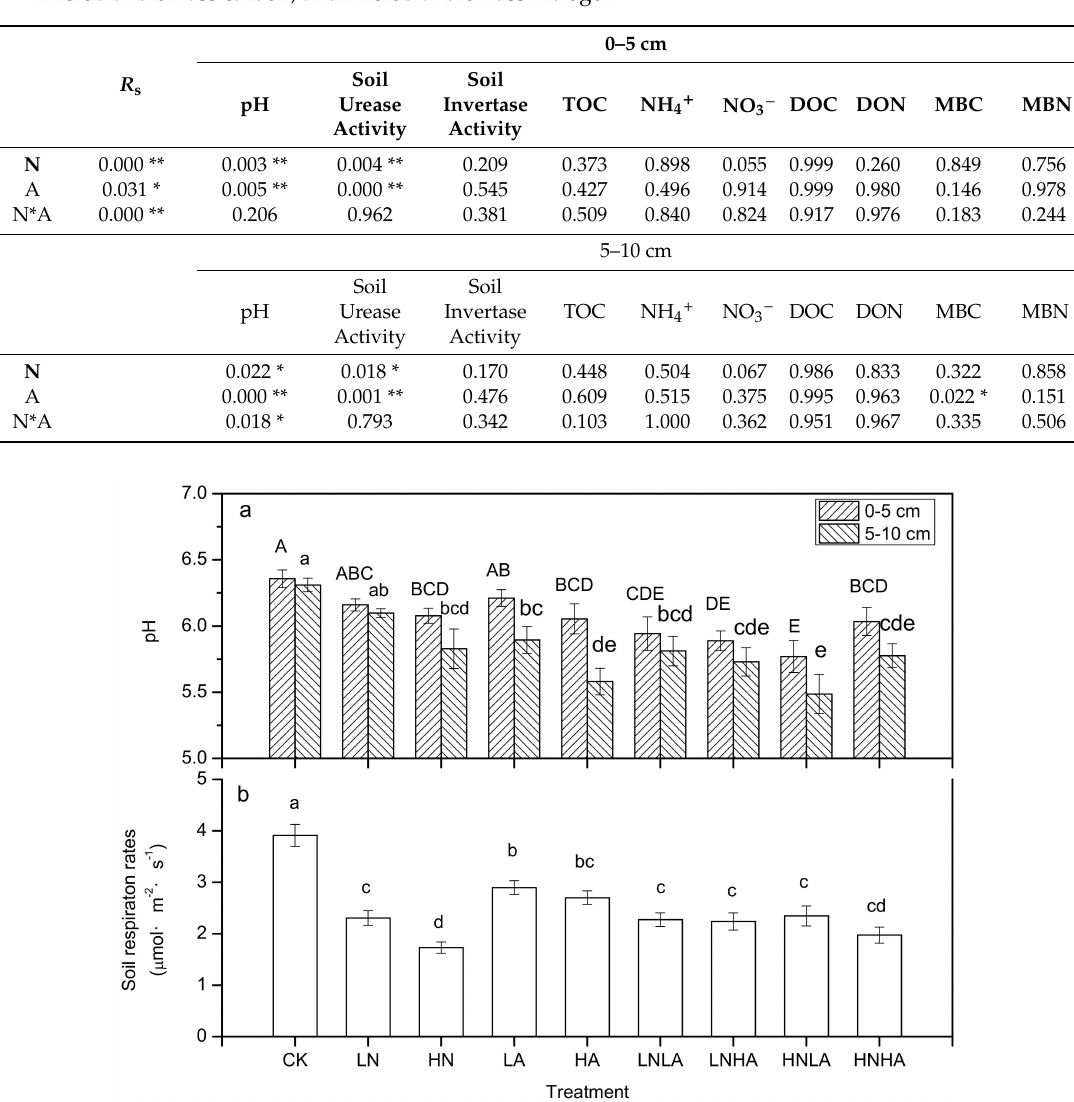
Figure 3. E ff ects of the experimental treatments on the soil pH ( a ) and annual soil respiration rate ( b ). Error bars indicate standard errors ( n = 8 in photo “a” and n = 40 in photo “b”). Di ff erent lowercase letters under di ff erent treatments indicate significant di ff erences at a p < 0.05